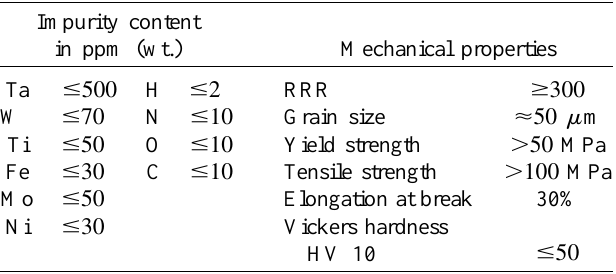
TABLE IV. Technical specification for niobium used in TTF